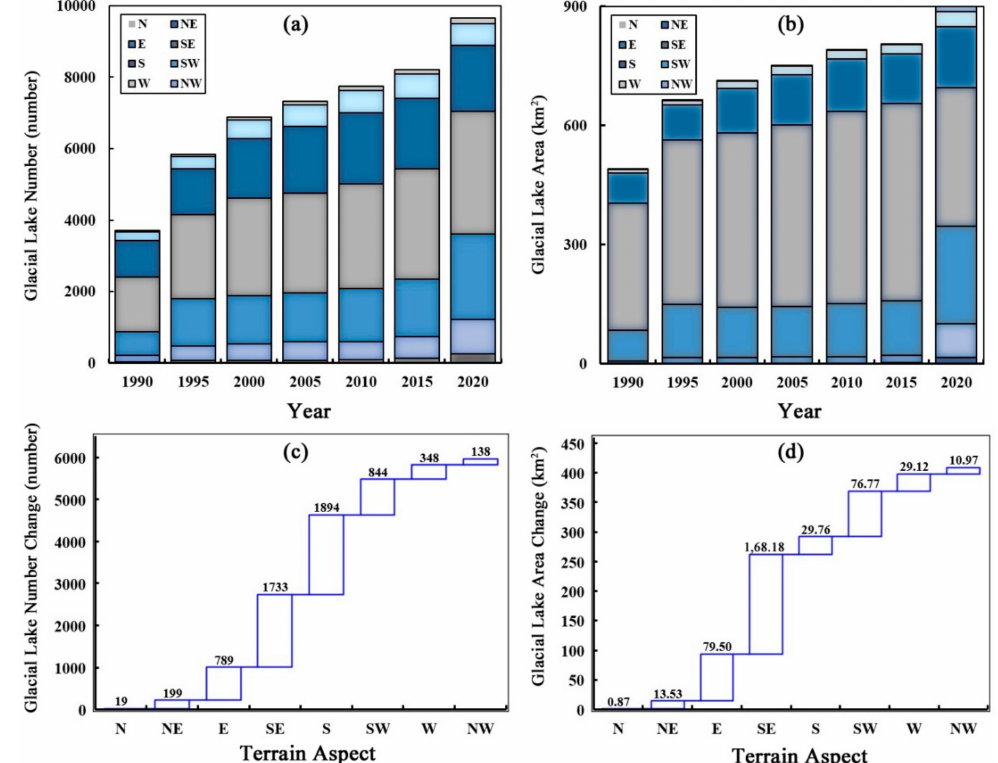
Figure 10. Distribution of glacial lakes with different terrain aspects in the HKH-TMHA region from 1990 to 2020: ( a ) Glacial Lake Number in 1990–2020, ( b ) Glacial Lake Area in 1990–2020, ( c ) Glacial Lake Number Change from 1990 to 2020, ( d ) Glacial Lake Area Change from 1990 to